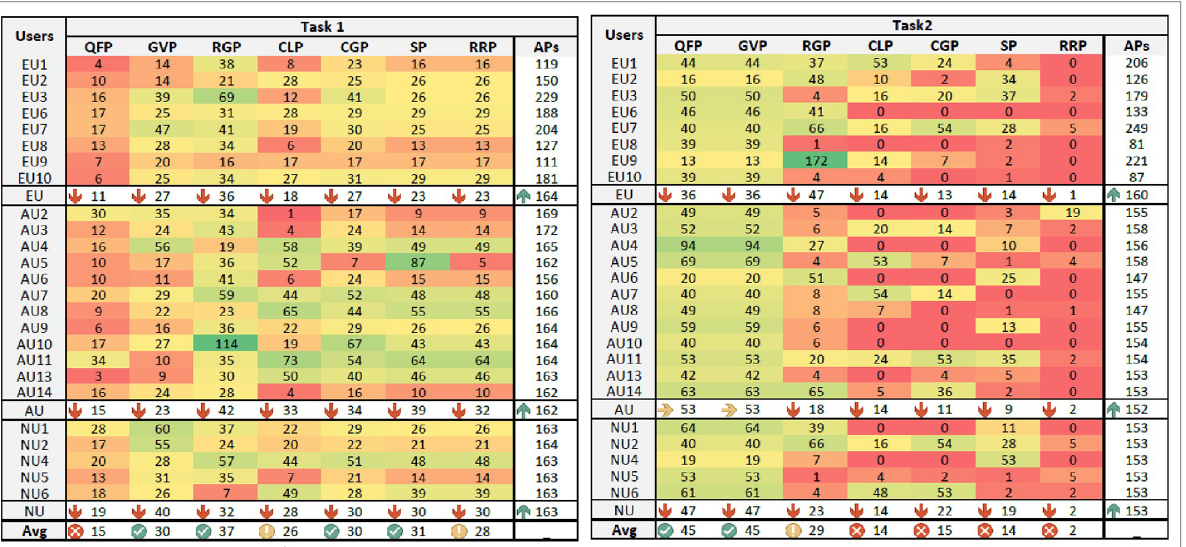
PLOS ONE | https://doi.org/10.1371/journal.pone.0280400 January 20,